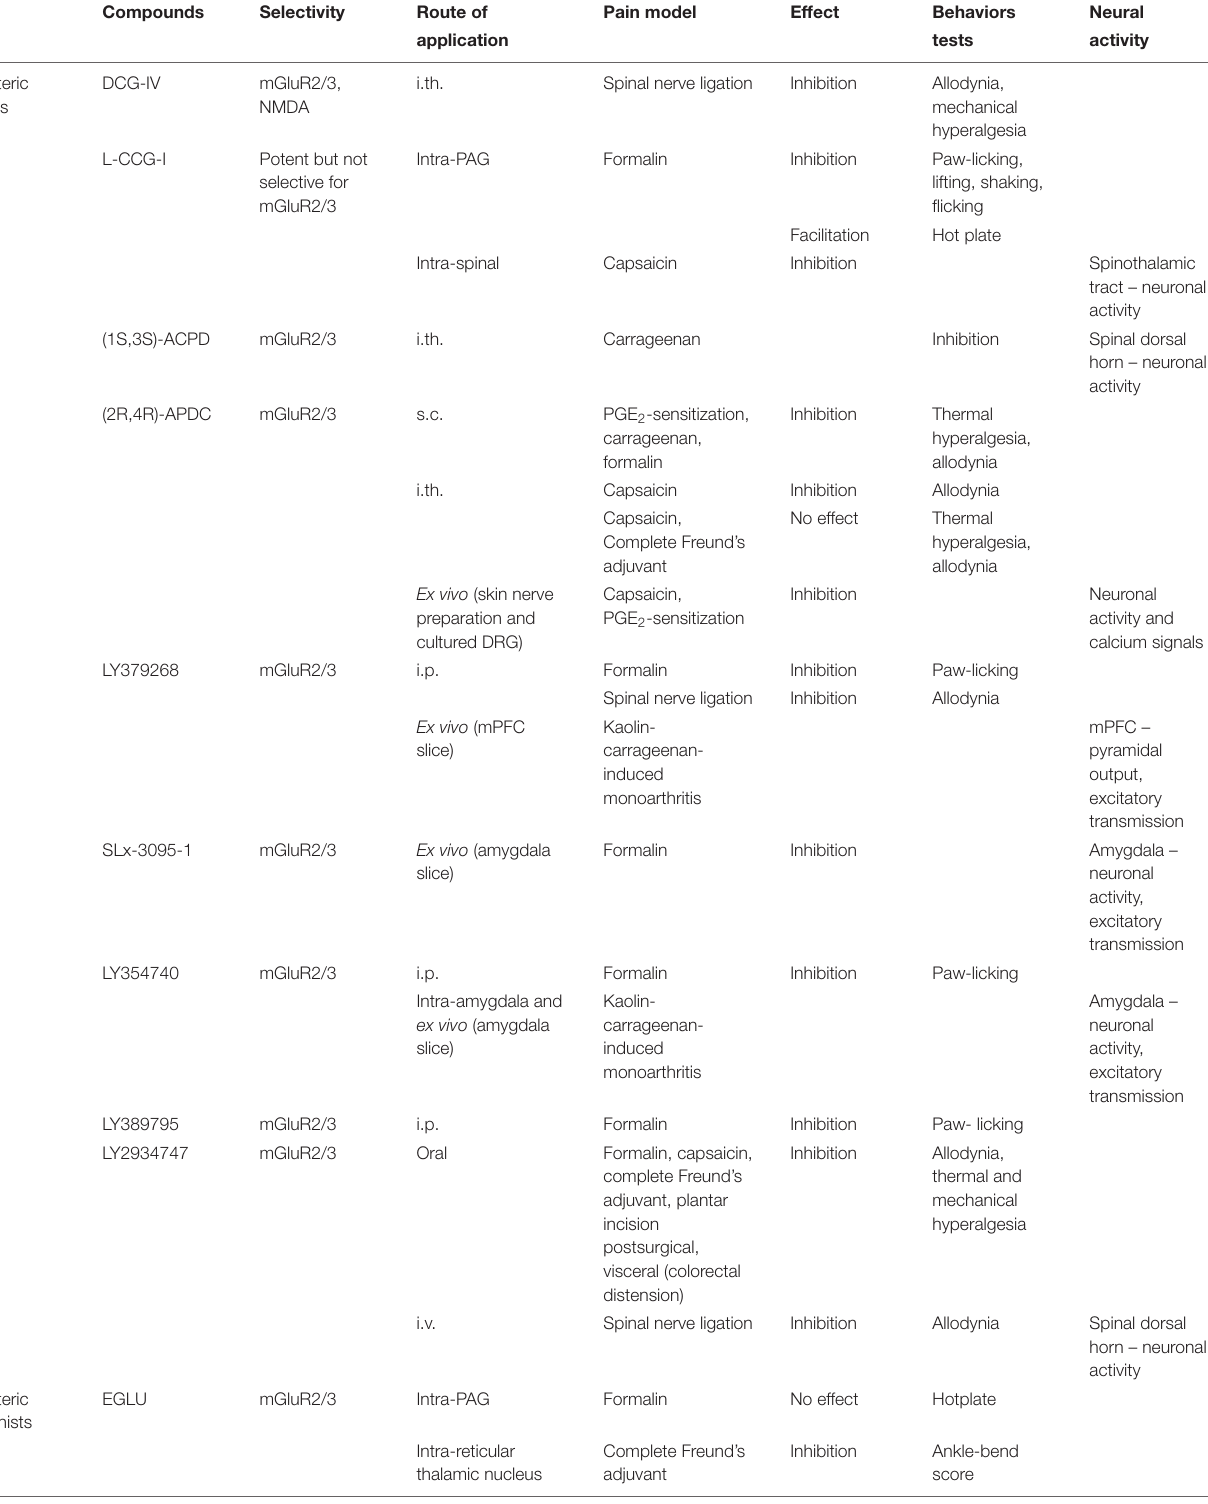
TABLE 1 | Drugs acting on mGluR2/3 tested in pain